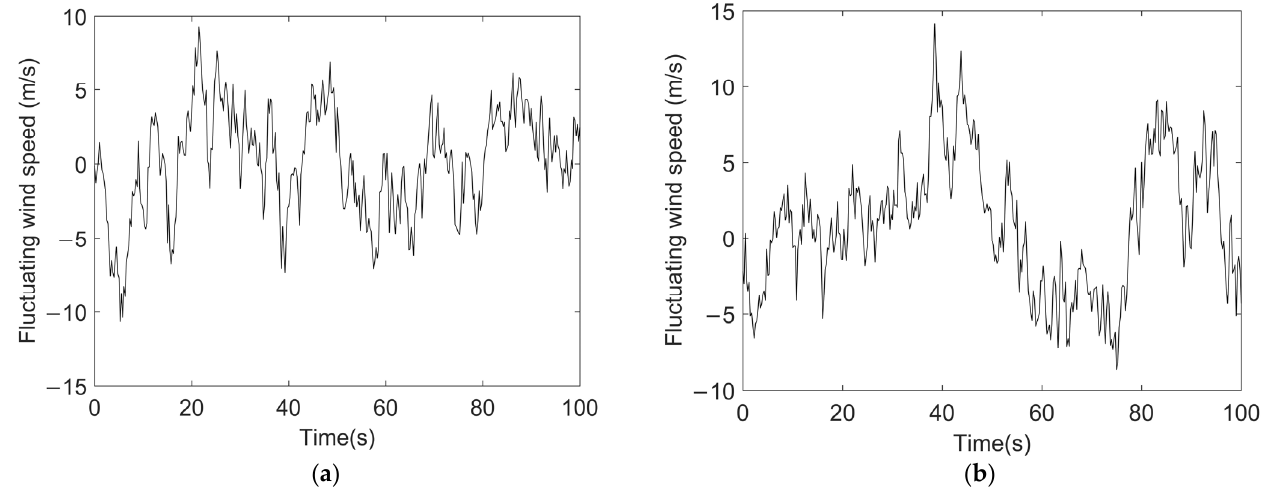
Figure 2. Simulated fluctuating wind speed at ( a ) 30 m level and ( b ) 60 m level.